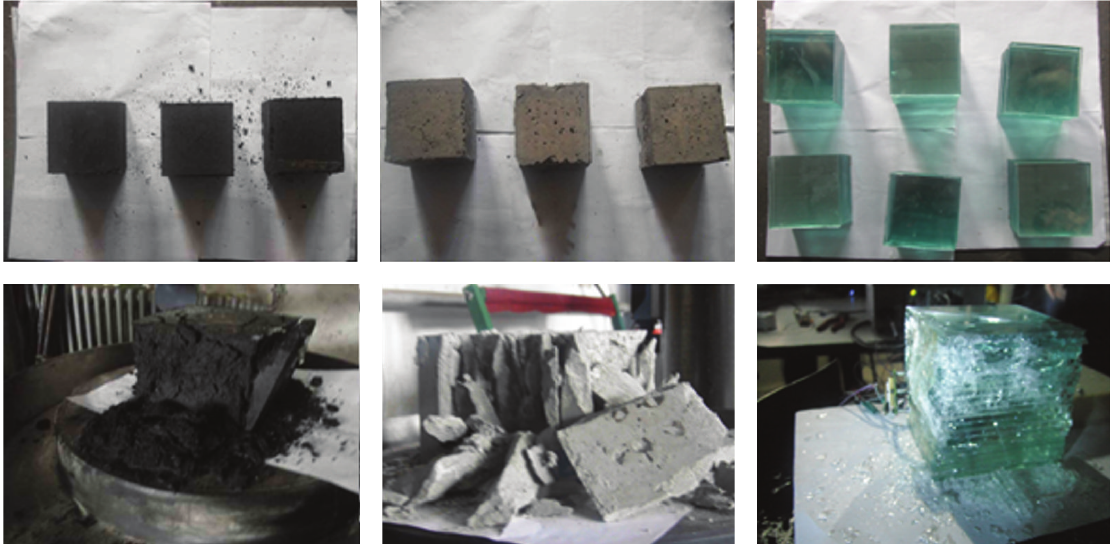
Figure 3: Original and damaged patterns of different types of